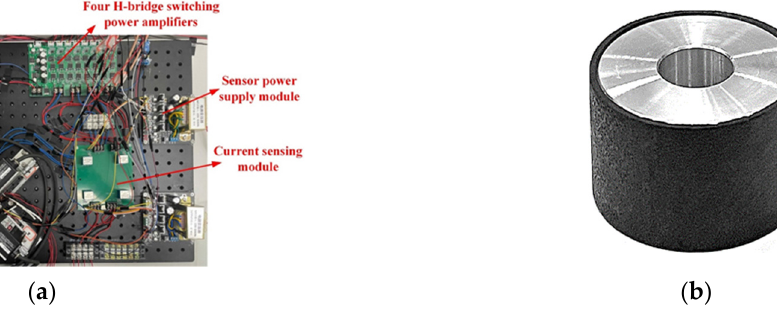
Figure 8. Picture of ( a ) the implemented MLSM system with the laser displacement sensors mounted on z -axis displacement platforms; ( b ) the rotor structure with Z F = − 1.9 mm. Table 2. Electromechanical specifications of the illustrated MLSM.